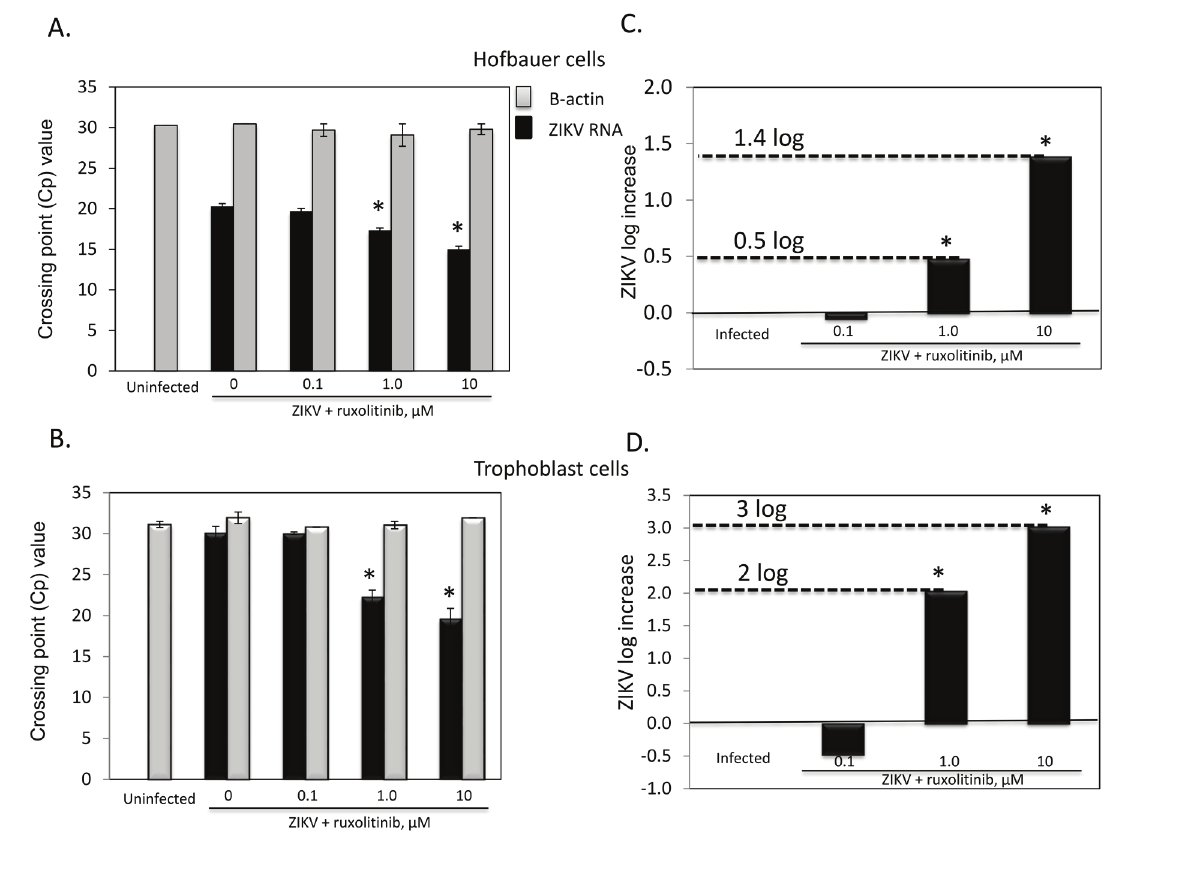
Figure 1. Effect of Jak1/2 blockade with ruxolitinib on permissiveness of primary human Hofbauer or trophoblast cells to ZIKV PRVABC59. Primary human Hofbauer cells (HC) or trophoblasts were permis- sive to PRVABC59 MOI 1 (A, B respectively; ZIKV RNA RT-PCR). The analysis was performed by using the sample crossing point (Cp) value which is the point at which an amplified product (fluorescence of a sample rises above the background fluorescence) is visible. Relative quantification was determined using the ZIKV RNA Cp values relative to infected/untreated controls. One or 10 µM ruxolitinib significantly increased virus replication versus infected/untreated controls in both cell types (A, B); * P < 0.01, One way ANOVA. Beta actin controls demonstrated that total cell numbers were not reduced across conditions and compared to uninfected controls (A, B, grey bars b-actin internal control, panels A, B). Ruxolitinib results in 0.5 to 1.4 log increase of ZIKV RNA replication in HC (C), and 2 to 3 log increase in trophoblasts (D); * P < 0.01, One Way ANOVA versus infected/untreated control. Infected cells were normalized to zero but had a crossing point value of 20 and 30 respectively for HC (A) and trophoblasts (B). Results were also normalized with endogenous beta actin